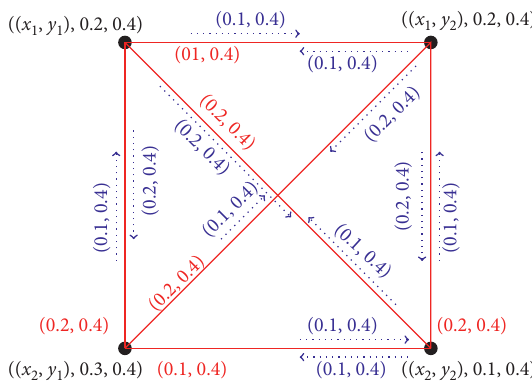
Figure 8: Composition of IFIGs given in Figures 5 and